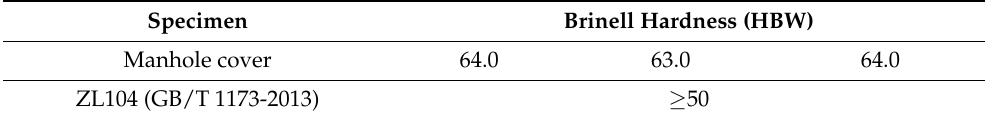
Table 2. Brinell hardness of manhole cover